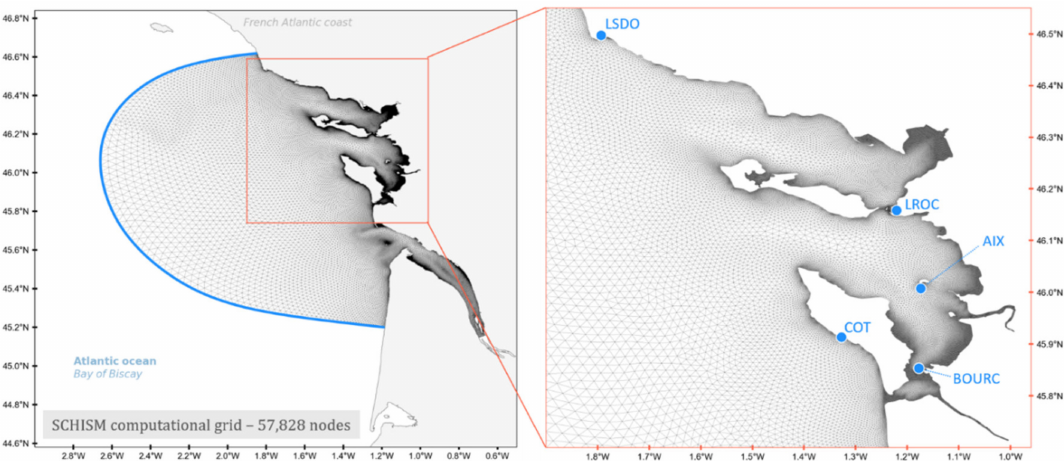
Figure 5. Computational grid (57,828 nodes) used in the two model configurations. The left panel gives an overview of the grid extent over the continental shelf, within the Bay of Biscay, where the open boundary is indicated by the blue line. The right panel displays a close-up view of the Pertuis-Charentais area, with the 5 tide gauges used for model validation (blue labelled